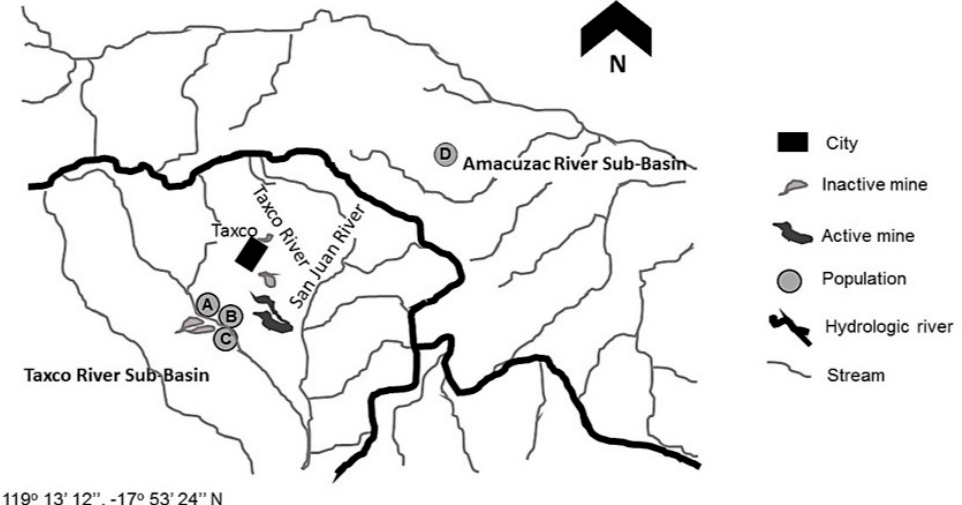
Figure 1. Communities distribution from the mining waste sites.